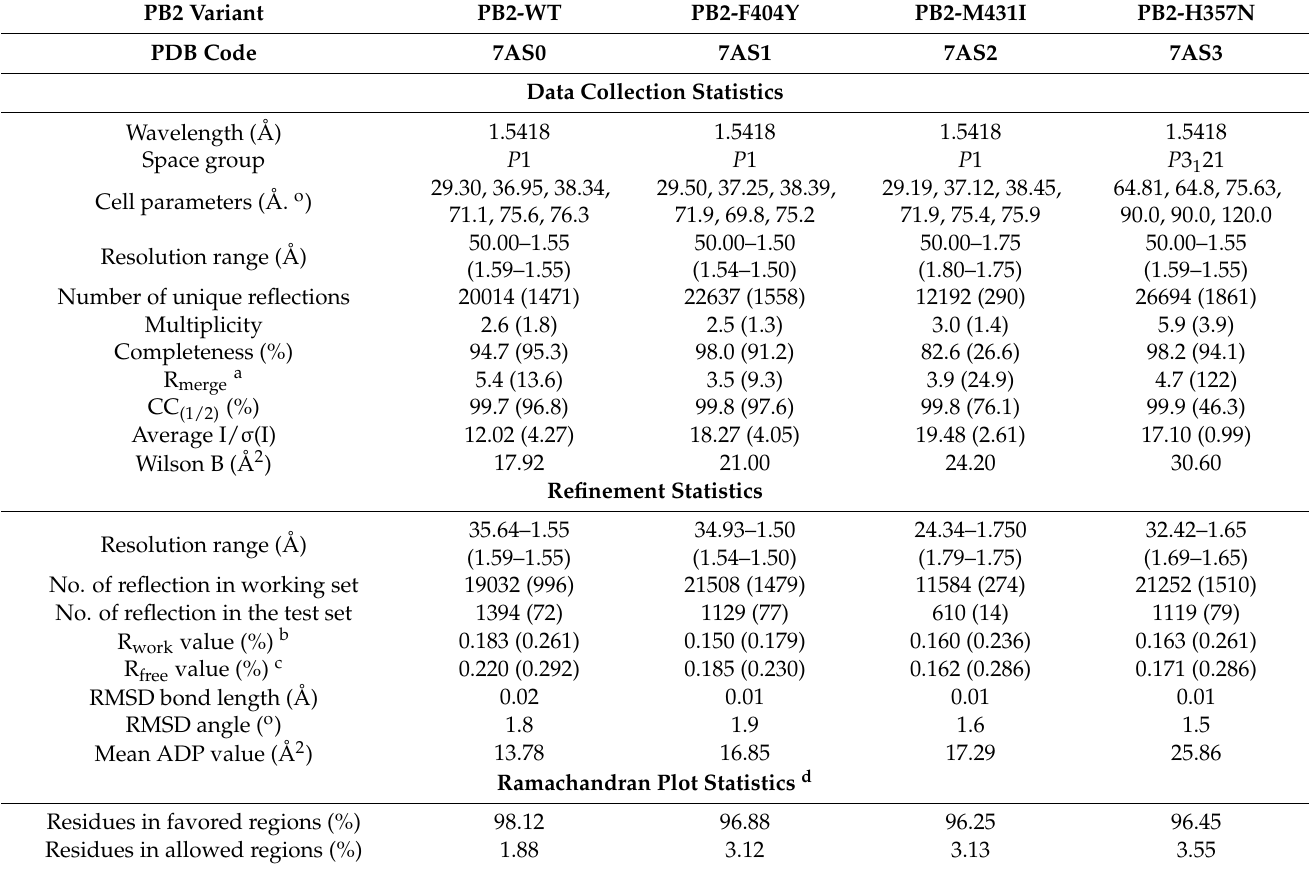
Table 4. Diffraction data collection and refinement